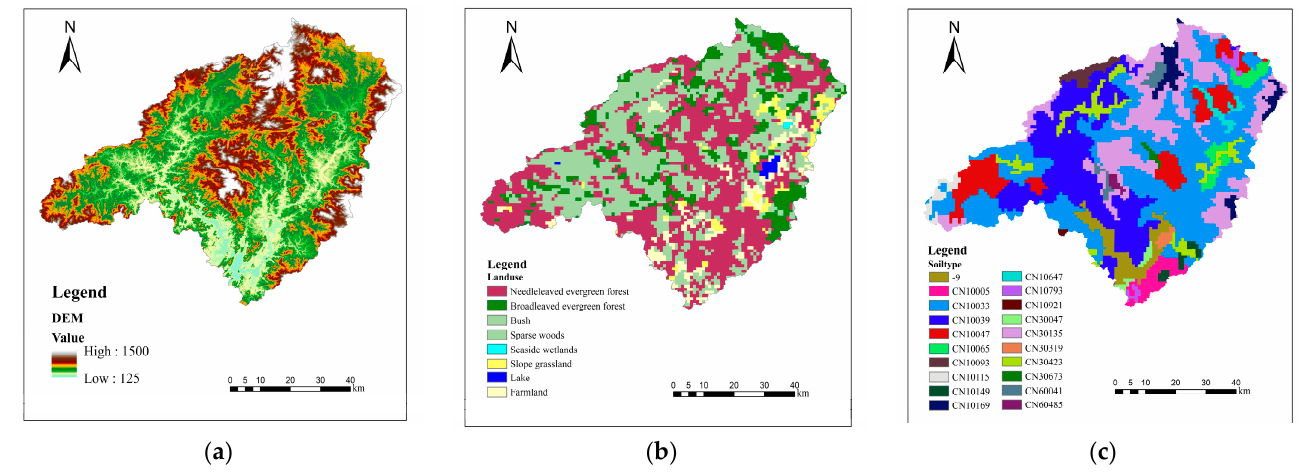
Figure 1. Globally available data of the Fengshuba Reservoir watershed. ( a ) DEM; ( b ) Land-use types; and ( c ) soil types.